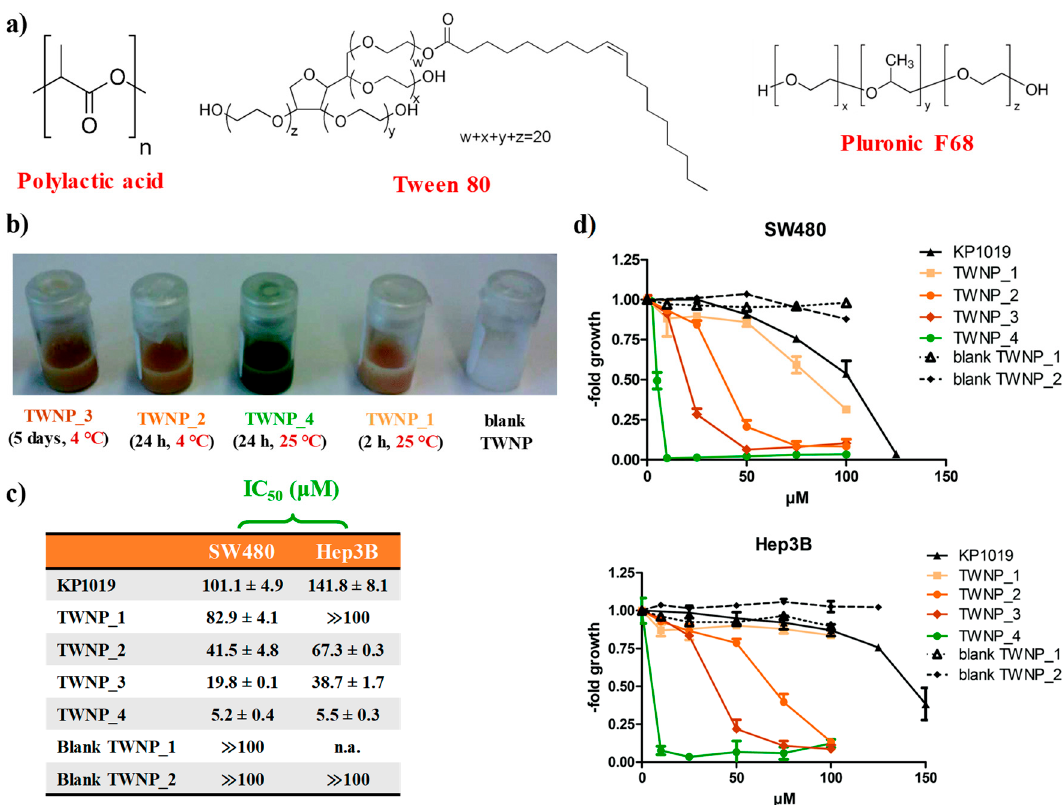
Figure 3. KP1019 incorporation into polylactic acid nanoparticles (PLA NPs): ( a ) chemical structures of polylactic acid and of the surfactant used in the formulation (poloxamer Pluronic F-68 and polysorbate Tween 80); ( b ) nanoparticle appearance after different temperature and period storage: TWNP_3 (5 d, 4 °C), TWNP_2 (24 h, 4 °C), TWNP_4 (24 h, 25 °C), TWNP_1 (2 h, 25 °C), blank TWNP, from left to right; ( c ) IC 50 values (µM) of the different KP1019 nanoformulations prepared in comparison with naked KP1019. Blank TWNP_1 (1 month, 4 °C), Blank TWNP_2 (2 h, 25 °C); IC 50 values are reported as mean ± SEM. ( d ) dose-response curves of colon carcinoma SW480 and the hepatoma Hep3B cancer cell lines with the indicated drugs as determined by MTT assay after 72 h treatment. Figures were adapted from [111] published by The Royal Society of Chemistry.